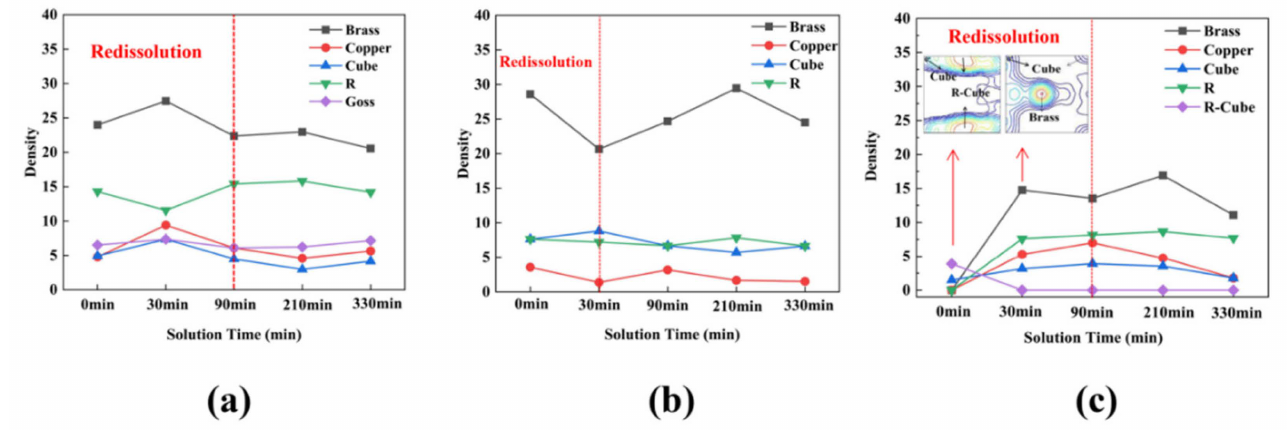
Figure 9. Curves of the texture orientation density after different solution times: ( a ) 25 mm, ( b ) 65 mm, ( c ) 120